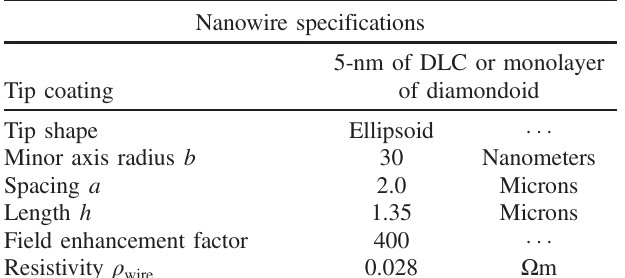
TABLE III. The nanowire specifications and metasurface and beam parameters for the metacathode. The NW specifications are based upon demonstrated SiNW properties [19].